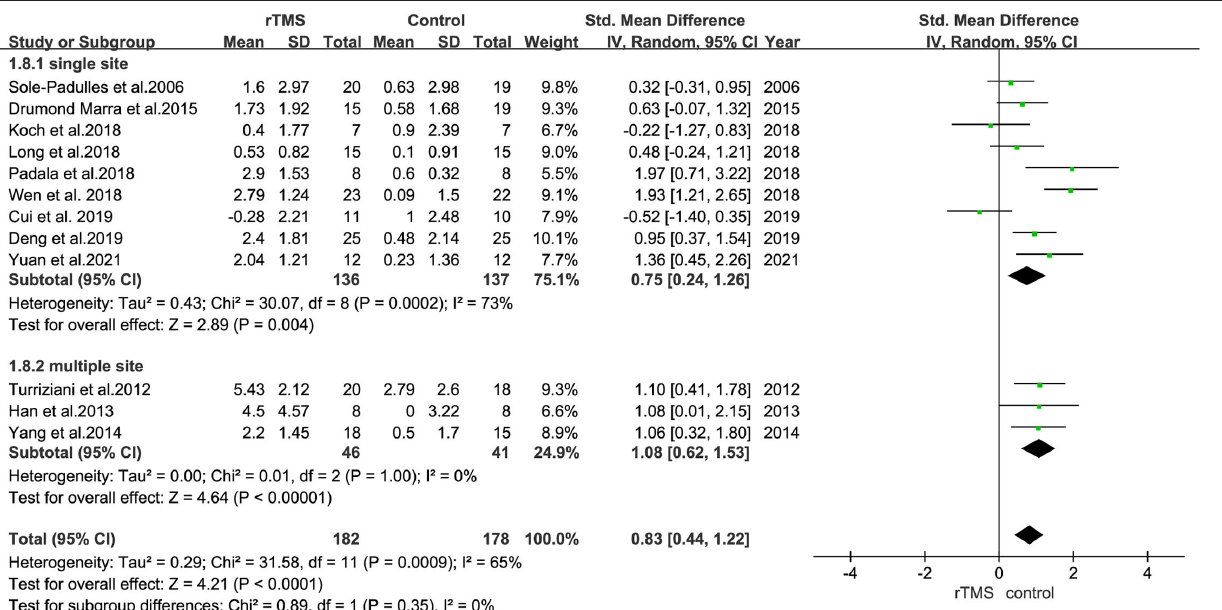
FIGURE 8 | A forest plot showing results of subgroup analyses for stimulation sites (single site vs. multiple sites). Mean differences in stimulation sites subgroup with 95% CI.